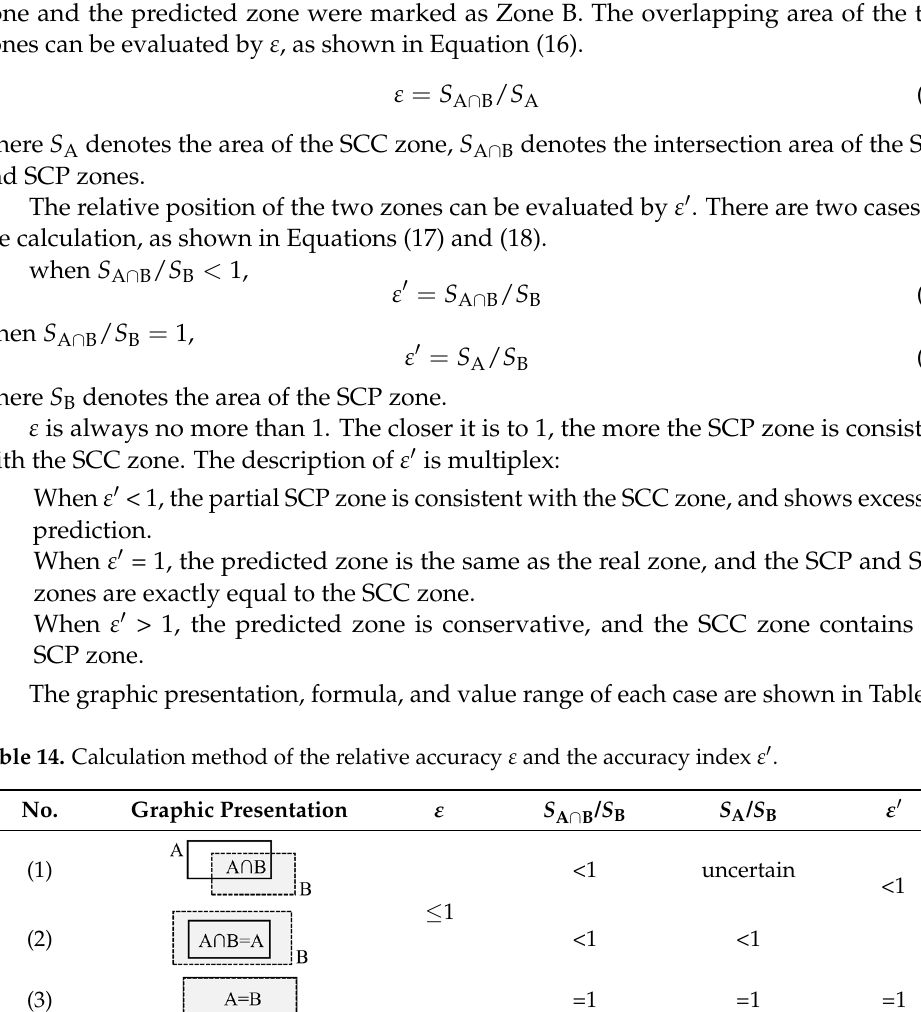
Table 15. Areas of SCP zone, SCC zone, and their intersected parts. Serial No.